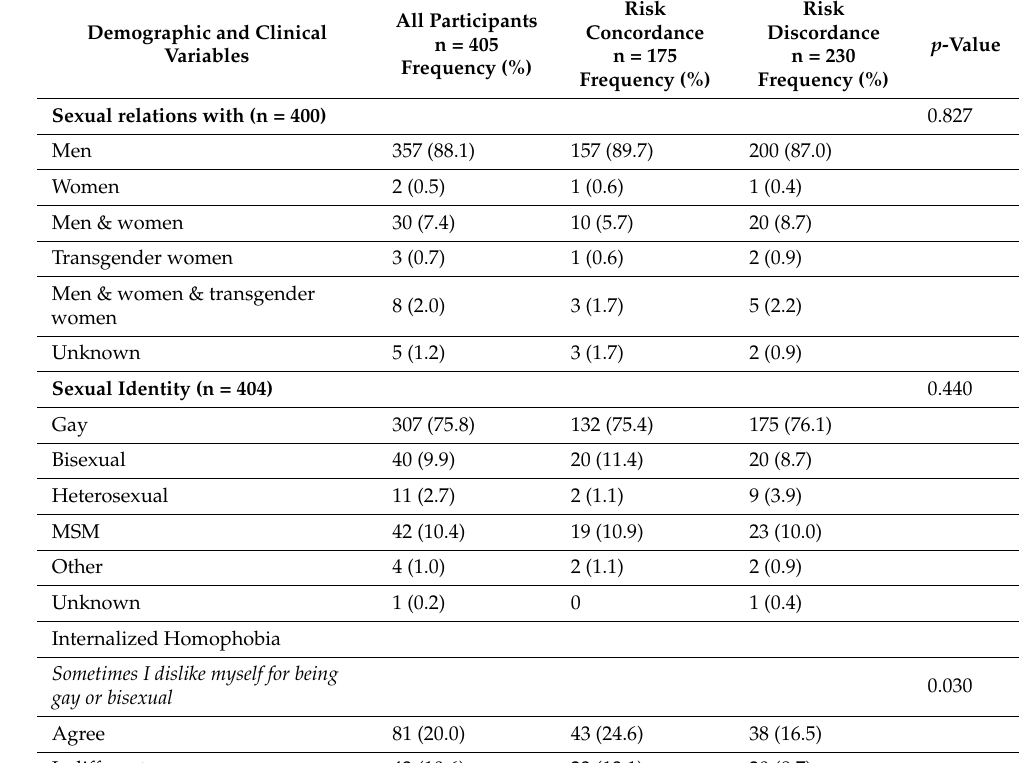
Table 1. Cont. Demographic and Clinical